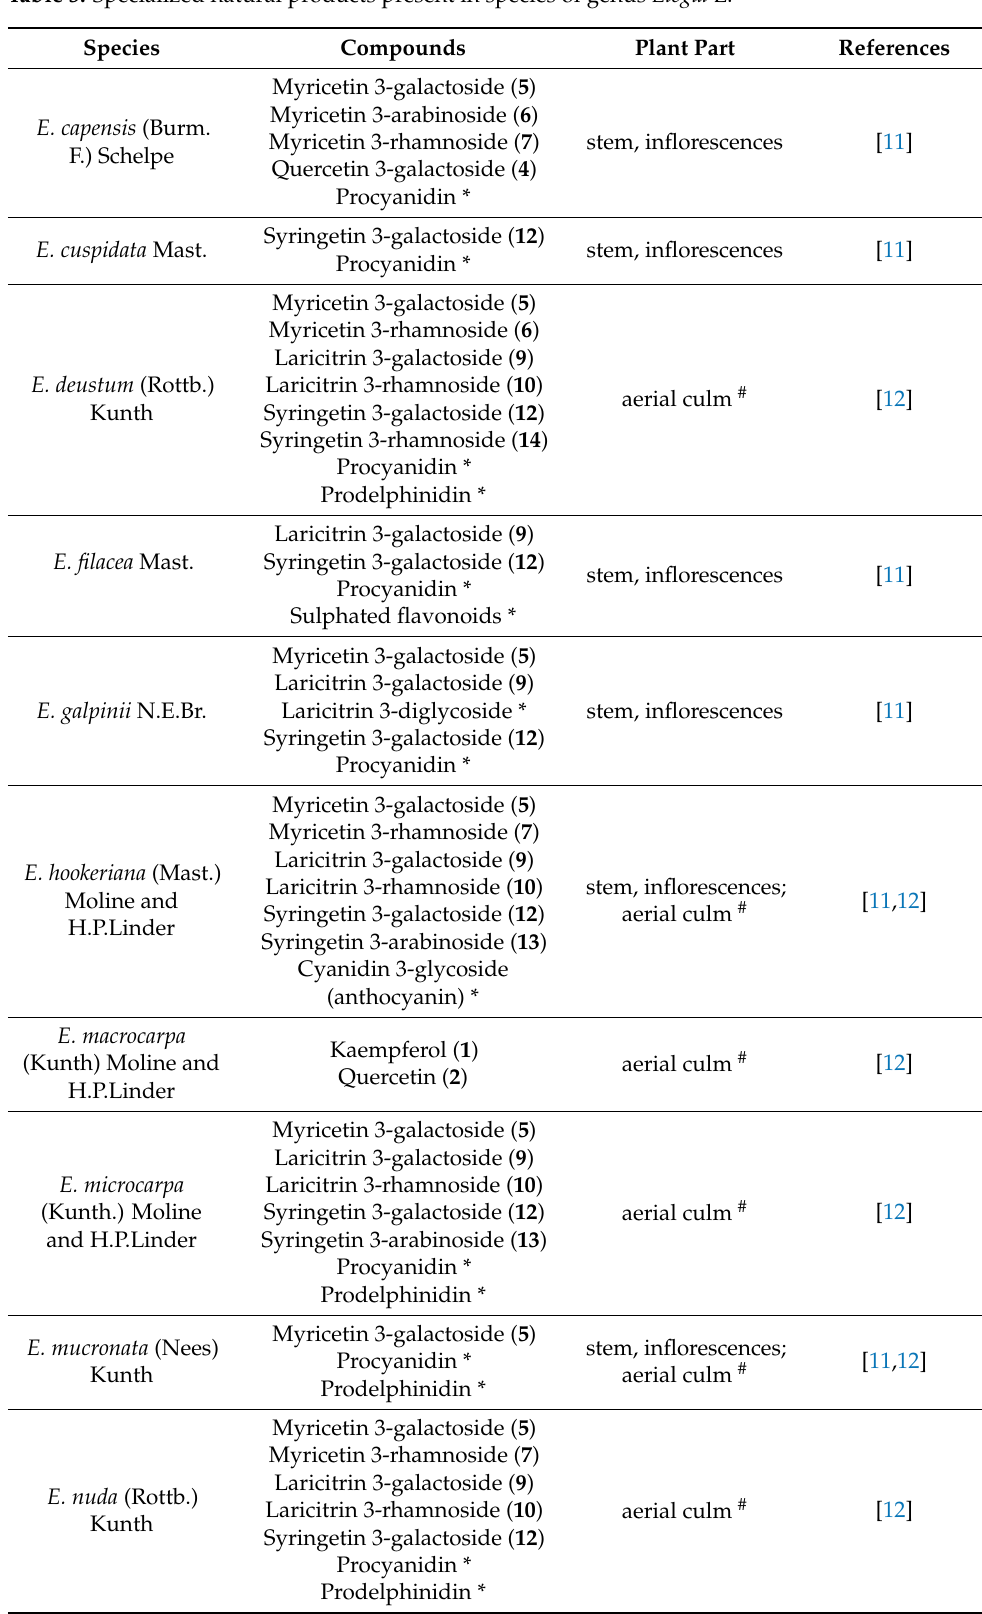
Table 3. Specialized natural products present in species of genus Elegia